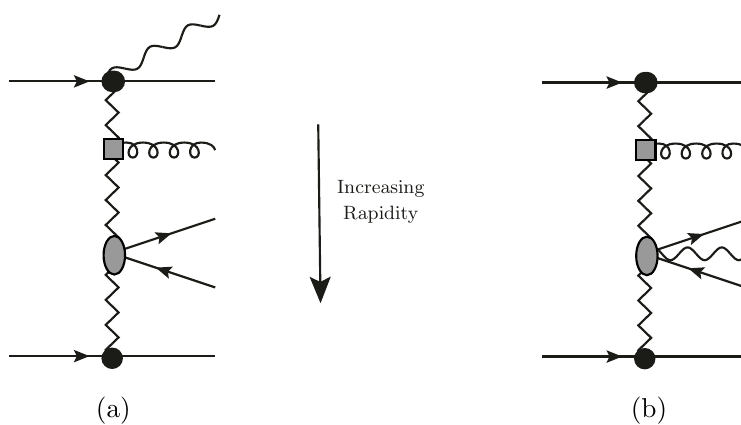
Figure 10. Two processes which contribute at next-to-leading log and are relevant for four jets and above: (a) q ˜ q → Wq 0 gQ ¯ Q ˜ q in that rapidity order which contains a central Q ¯ Q pair and W produced from a different quark line, and (b) q ˜ q → qgQ ¯ Q 0 W ˜ q in that rapidity order where the W is produced from the central Q ¯ Q 0 -pair. The rapidity-ordering applies to the coloured particles and not to the W boson or its decay